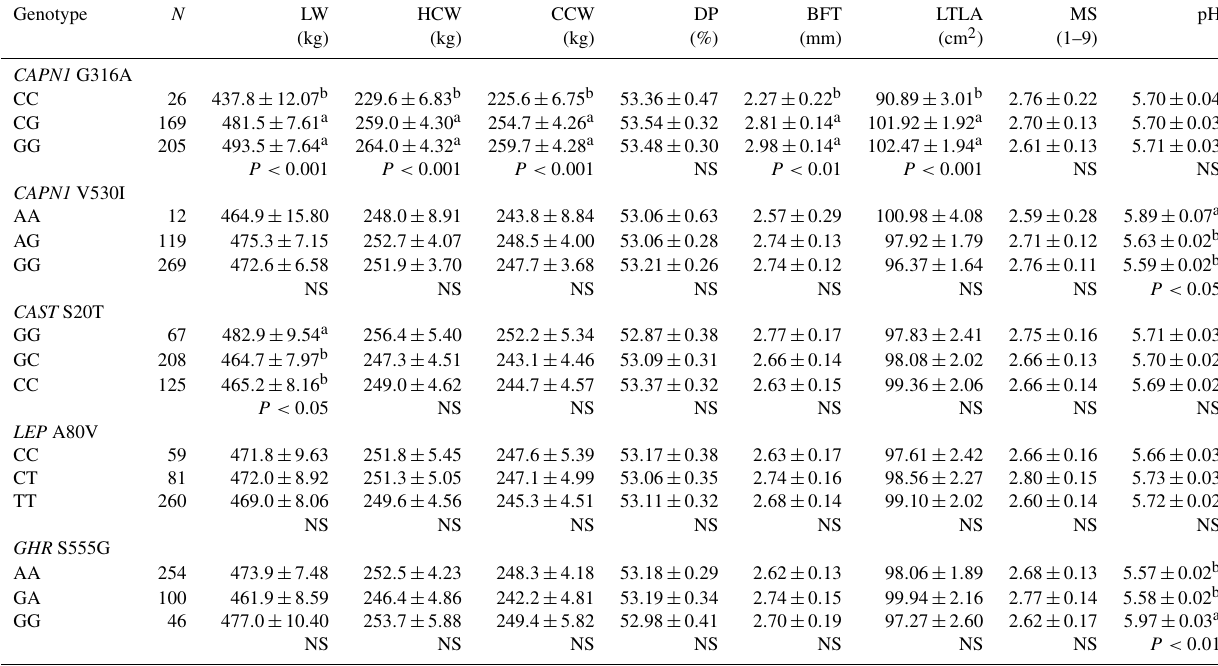
Table 3. Levels of significance, least-squares means, and standard errors for the effect of CAPN1 , CAST , LEP and GHR on carcass traits and meat quality in a Holstein population.